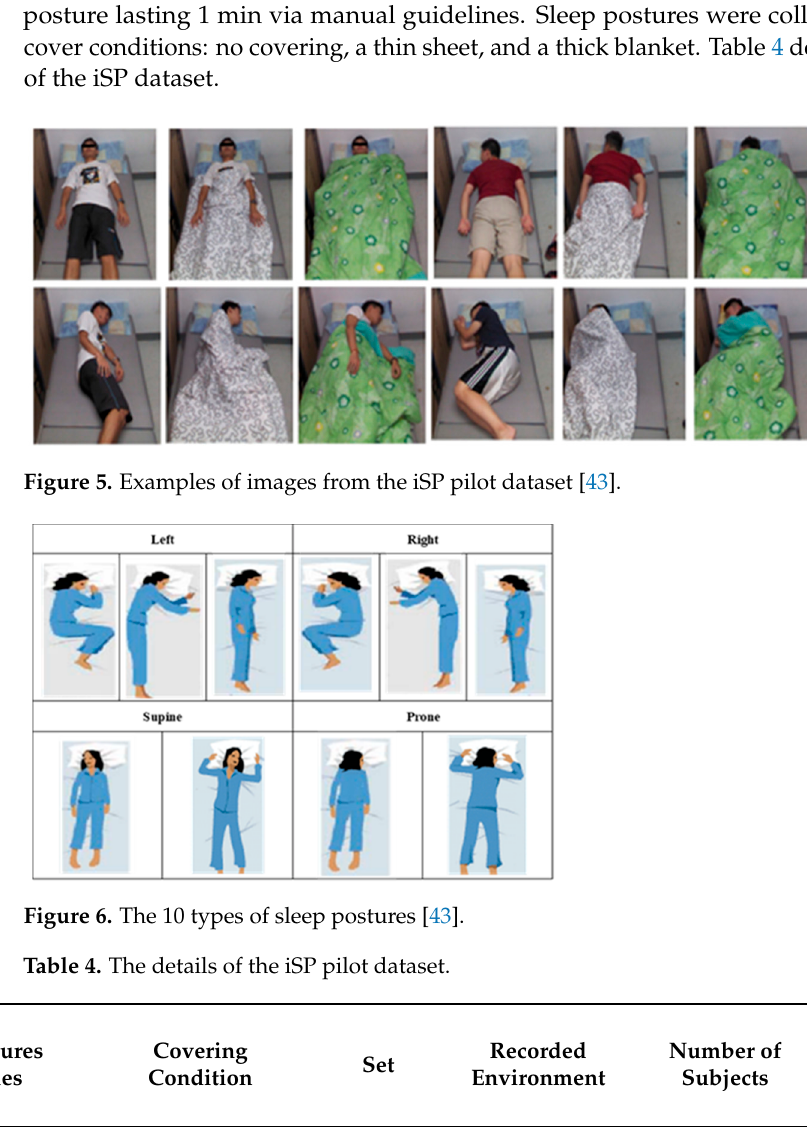
Figure 4. Illustration of the system in the experiment [43].